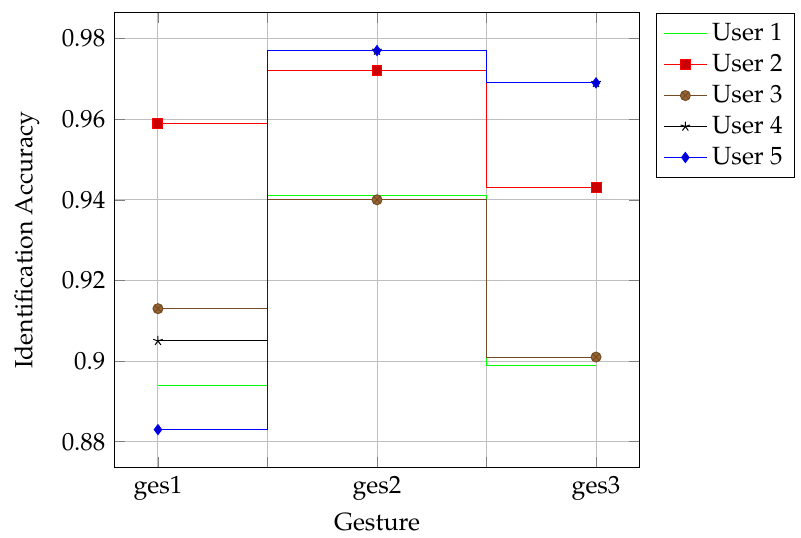
Figure 6. Cross-behavior identification rate of